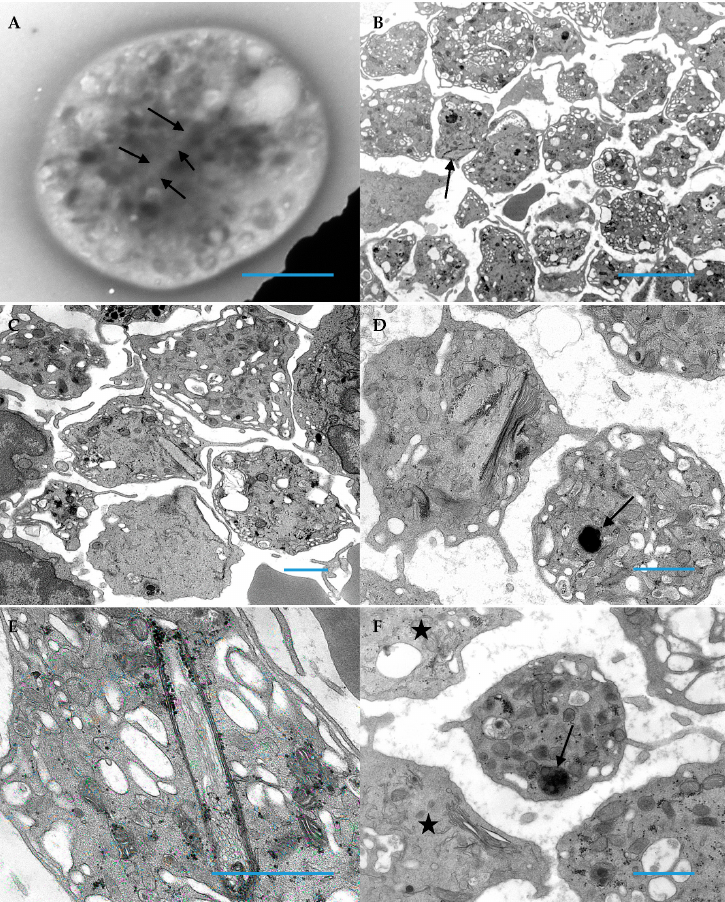
Figure 3. Platelets from patient 2 demonstrate the character inclusions common for Medich syndrome. ( A ) This image demonstrates a faint outline (arrows) in a whole mounted, air-dried platelet; these are almost impossible to visualize when entirely within a cell, unlike inclusions that protrude from the cell and create a stark deformation of the discoid platelet shape (Original magnification 11,000×; Blue Bar = 1 micron). ( B ) Macrothrombocytes having vacuolated cytoplasm are readily apparent with one having a peripheral inclusion (arrow) (Original magnification 4,800×; Blue Bar = 10 microns). ( C ) An inclusion in the center of this image is protruding from a platelet (Original magnification 8,000×; Blue Bar = 1 micron). ( D ) Adjacent platelets demonstrate the two morphologic characteristics of Medich syndrome; one platelet has a giant alpha granule (arrow), whereas the second platelet has 2 scroll shaped inclusions (Original magnification 13,000×; Blue Bar = 1 micron). ( E ) The image demonstrates black granular aggregates of glycogen associated the multi-membranous “scroll” inclusion in a grey platelet (Original magnification 30,000×; Blue Bar = 1 micron). ( F ) In this image, two gray platelets (stars) absent of alpha granules are demonstrated and an additional platelet has a giant alpha granule (arrow) in contrast to the normal size of alpha granules populating the platelet (Original magnification 11,000×; Bar = 1 micron).